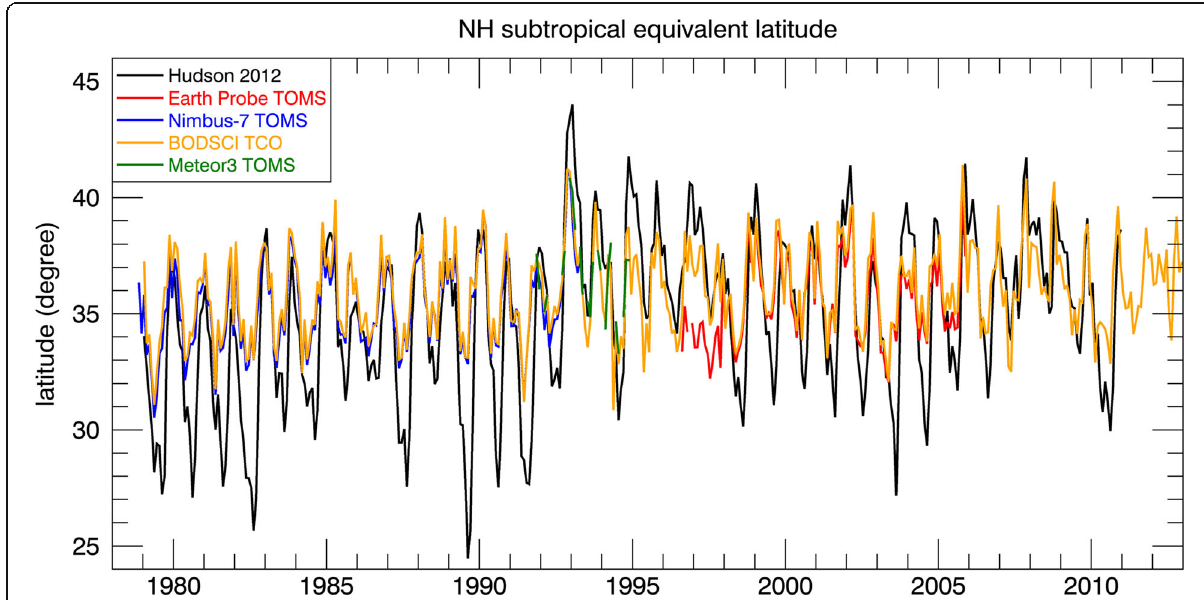
Fig. 1 Timeseries of total column ozone-based subtropical front equivalent latitude in the Northern Hemisphere from five different data sources. Calculations from Hudson 2012 are in black, and the colored lines are our calculations from four different TCO data